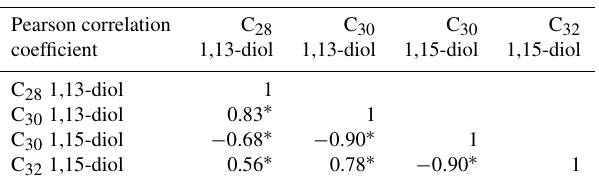
Table 2. Pearson correlation coefficient analysis of different diols in surface sediments in this study ( ∗ p < 0 . 005). Pearson